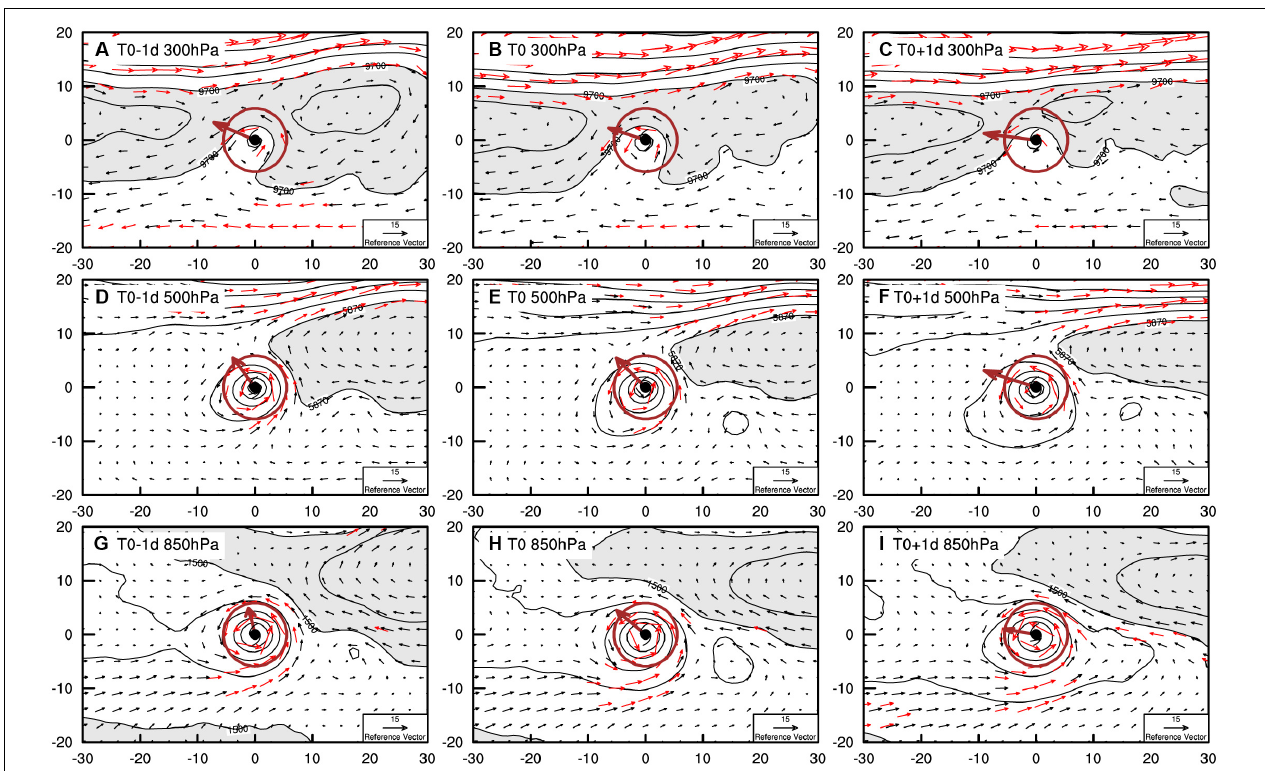
FIGURE 5 | Composite unfiltered winds (vectors, m s − 1 ) and geopotential height (contour, gpm) for the SLT cases (left) 1 day before, (middle) at and (right) 1 day after the turning time. Pressure levels are (A–C) 300 hPa; (D–F) 500 hPa; and (G–I) 850 hPa, respectively. The areas larger than 9700, 5870, and 1510 gpm at respective level are shaded. Red vectors represent wind speeds larger than 8 m s − 1 . The coordinates are the latitudes and longitudes centered on TC center. The brown vector means the composite steering flow averaged in the brown circle.